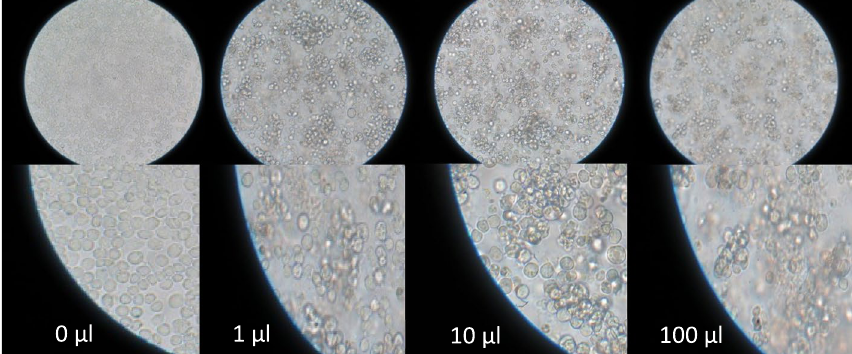
Fig. 2 Estimation of viral titer by sequential dilutions method. The Sf9 insect cells inoculated with 1, 10, and 100 μl of P3 baculoviral seed showed almost the same CPEs and thus had the titer of 2 10 8 ×